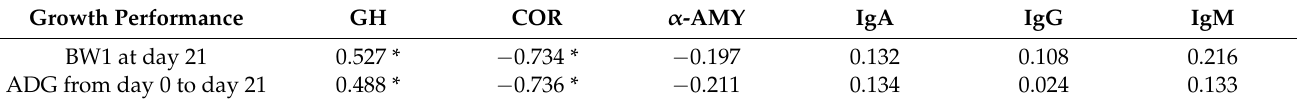
Table 5. Correlation analysis between growth performance and plasma